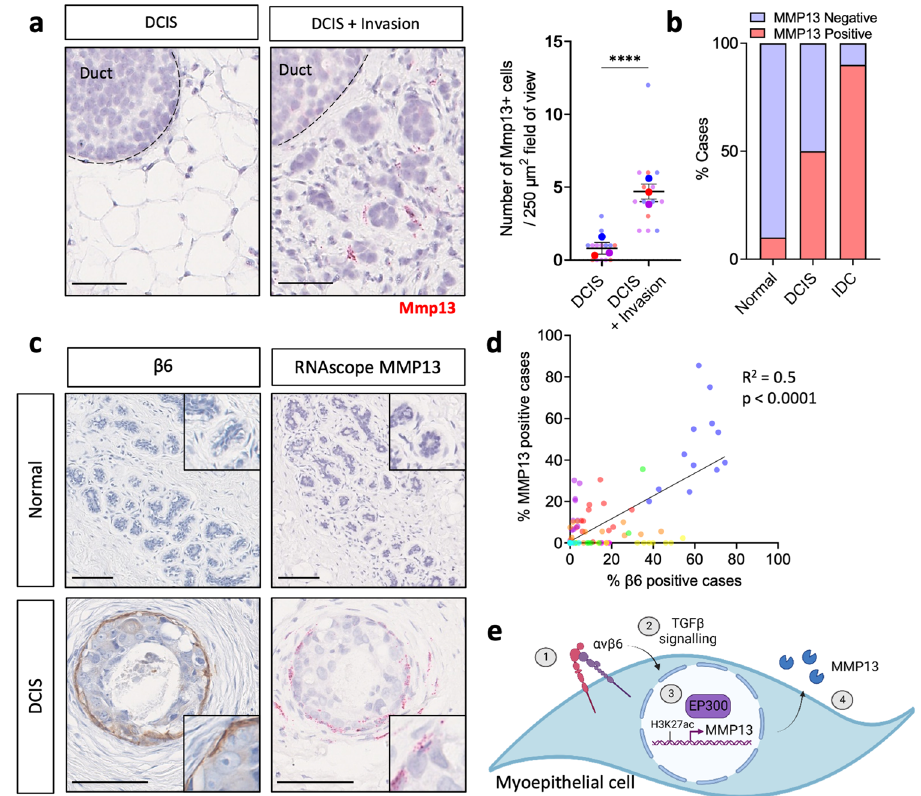
Fig. 7 MMP13 expression is associated with invasion in a mouse model of DCIS and in human samples. a Representative Mmp13 RNAscope images of non-invasive and invasive fronts from MCF7-MIND mice at 12 weeks post intraductal injection. Mmp13 expression is indicated by presence of red dots. Graph shows number of Mmp13 + cells per 250 µm fi eld of view. n = 3 mice. Scale bar = 50 µm. b Summary graph showing percentage of MMP13 positive patients across normal ( n = 10), DCIS ( n = 10) and IDC ( n = 10) cases. c Representative images of β 6 IHC (brown) staining and MMP13 RNAscope (red) detection in normal and DCIS patients. Scale bar = 100 µm. d Graph showing percentage of MMP13 and β 6 positive cells/per duct across DCIS patients. Data are presented as individual points where each dot represents one duct, with different patients represented by different colours (12 DCIS ducts quanti fi ed per patient) (Simple linear regression). e Schematic showing proposed mechanism where myoepithelial β 6 expression drives TGF β -dependent activation of EP300 to regulate MMP13